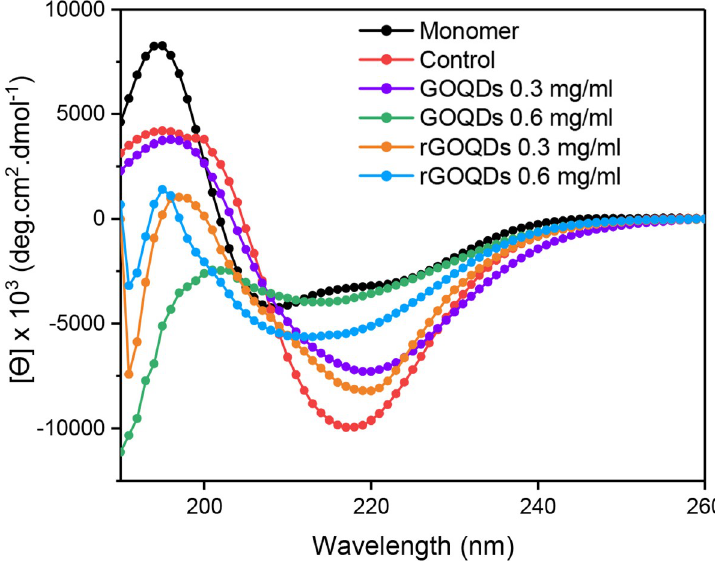
Fig 5. Effect of GOQDs and rGOQDs on the secondary structural changes of bovine insulin incubated under amyloidogenic conditions. Further details are described in Material and methods section.